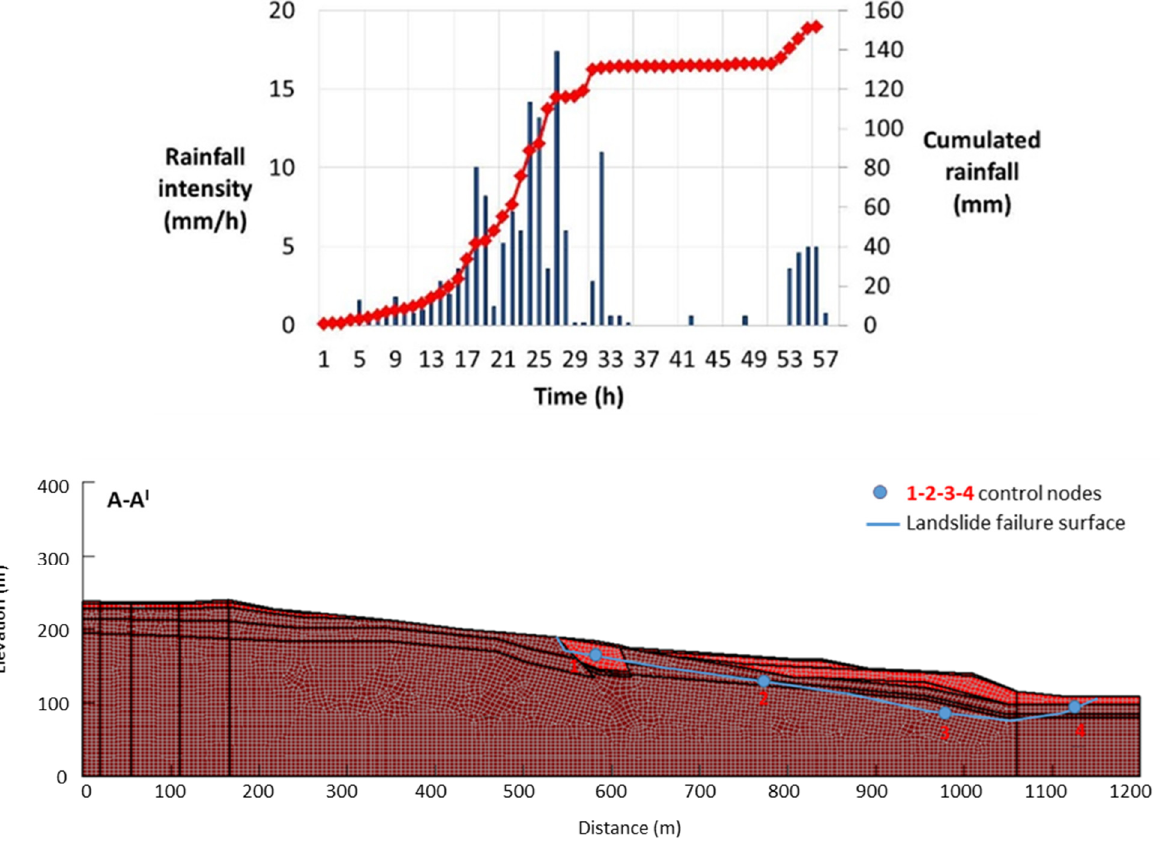
Figure 5. Above, the plot of the rainfall intensity with time during the event that triggered the 2013 Montescaglioso landslide. Below, the seepage domain adopted for the SEEP/W transient analysis: discretization mesh and boundary conditions. The failure surface of the landslide is also reported, along with the location of the control nodes (1–4) used to follow the variation of the pore water pressures with time (see text for further details).